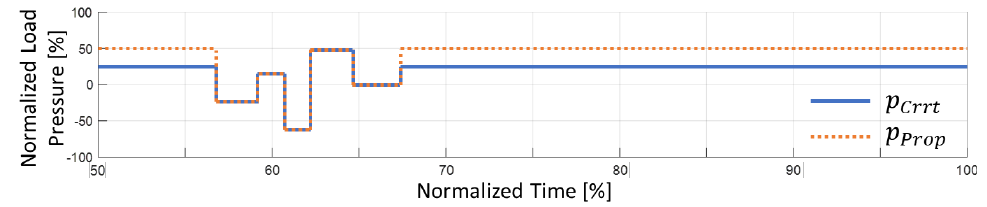
Figure 20. Normalized motor load. Comparison between the Standard system vs. Solution A.